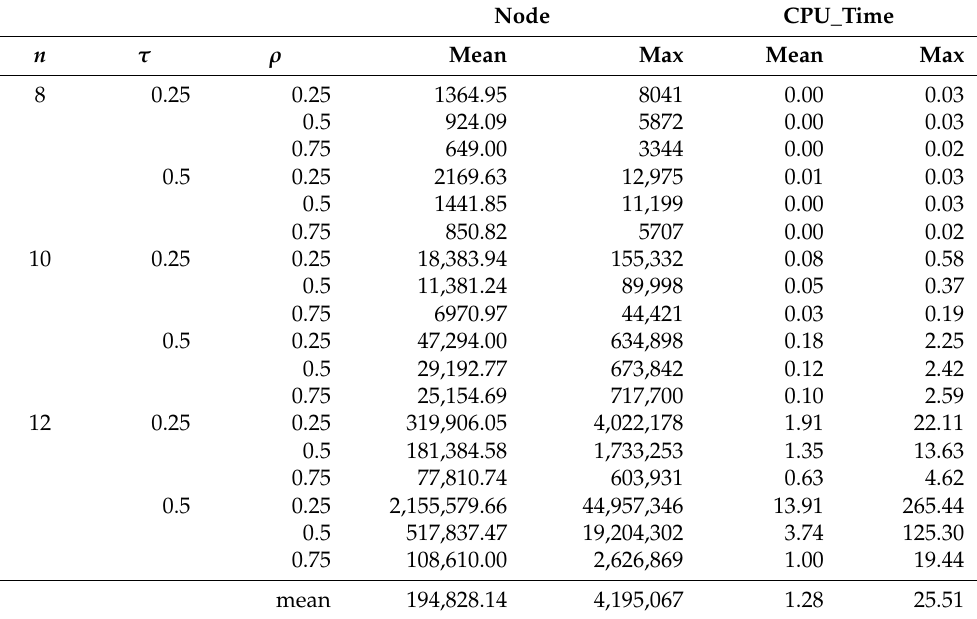
Table 1. The behavior of the B&B.